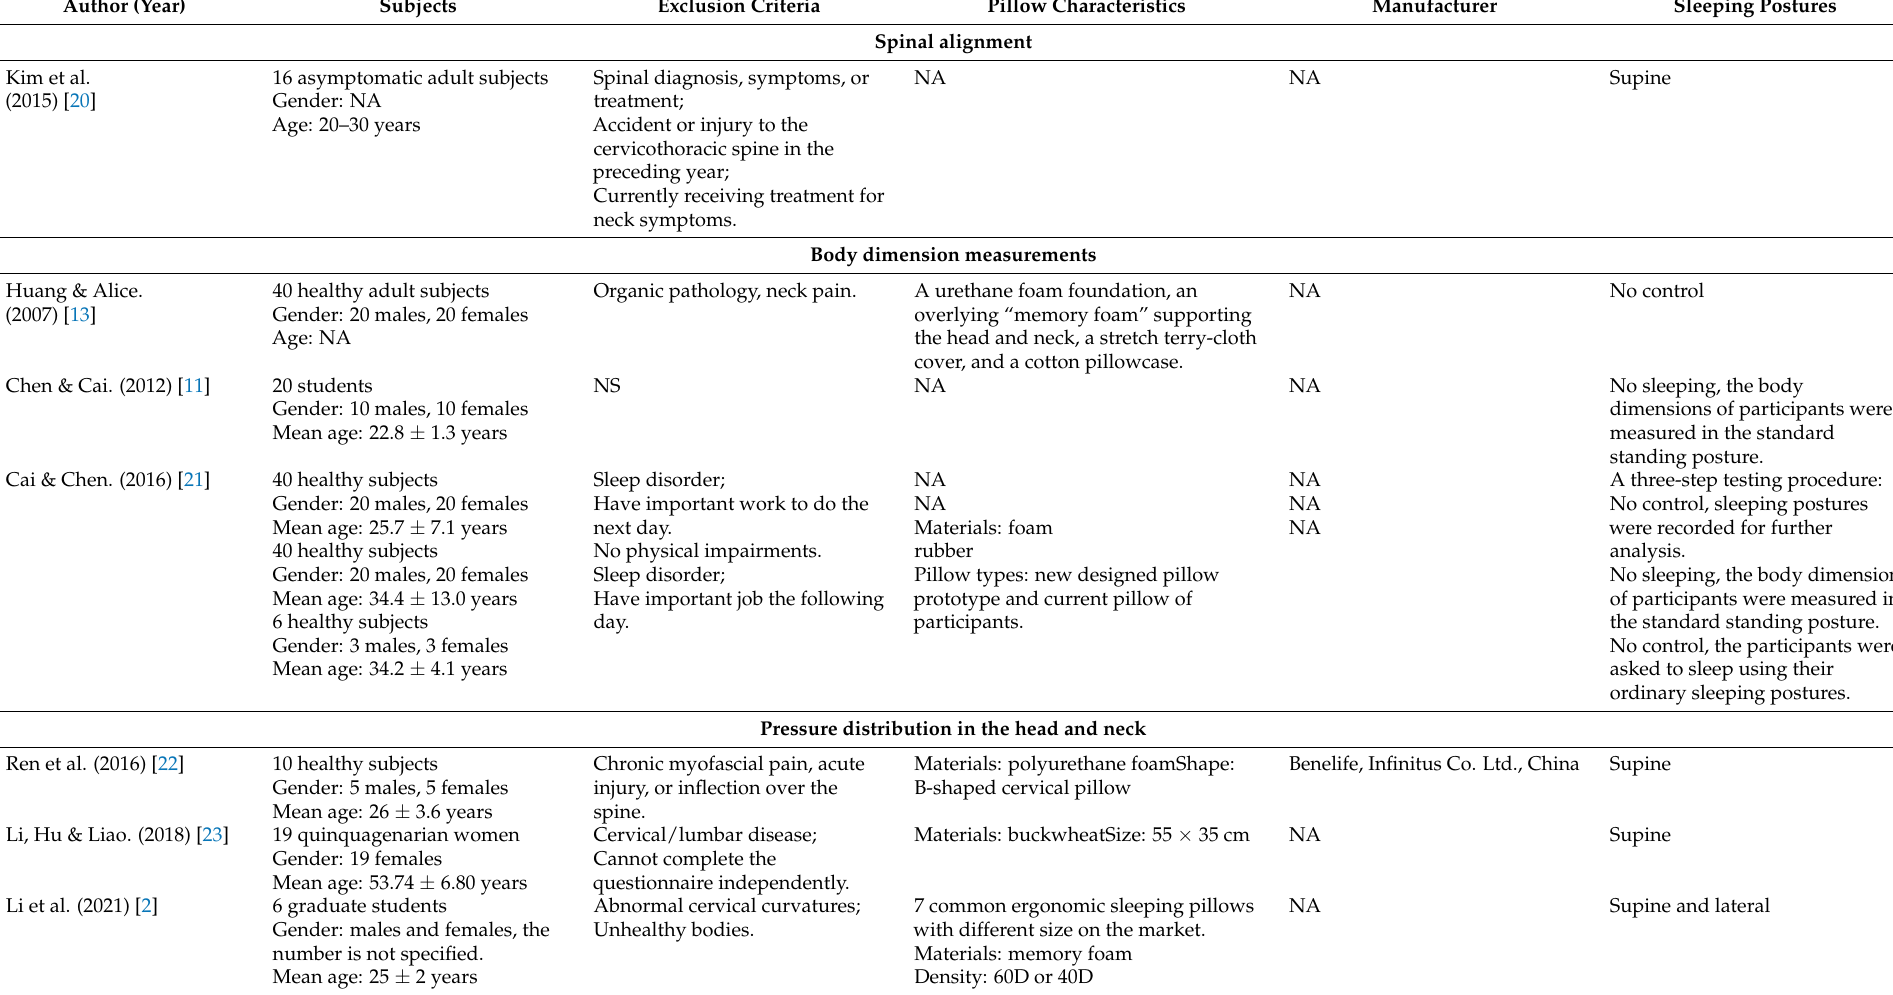
Table 1. Selection of subjects and pillow samples in the reviewed